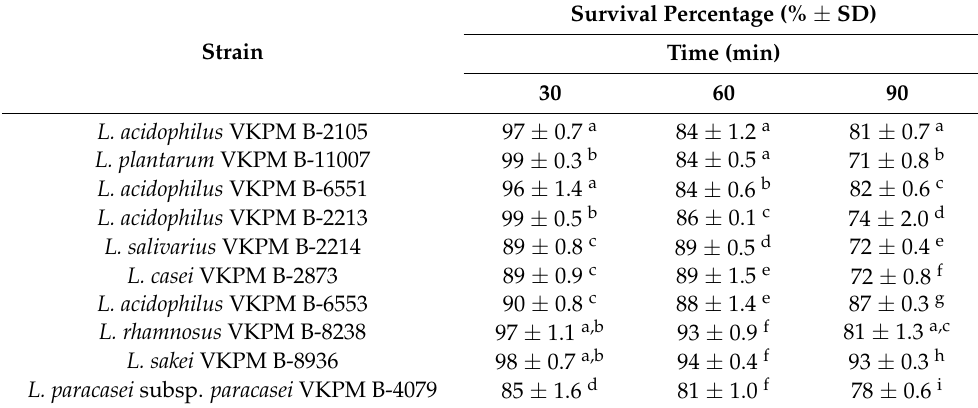
85 ± 1.6 d 81 ± 1.0 f 78 ± 0.6 i